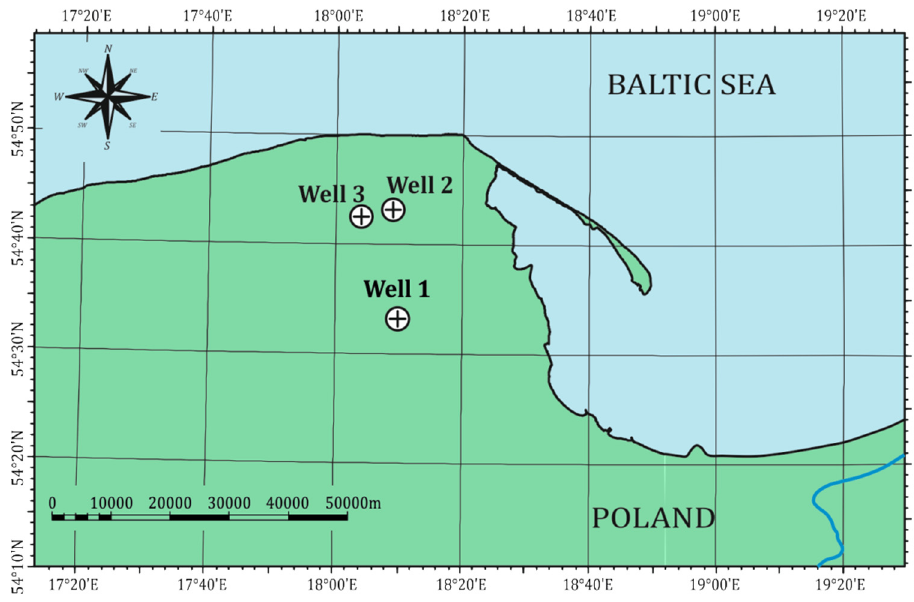
Figure 1. Locations of Well-1, Well-2 and Well-3 in the study area, north Poland, Peri-Baltic Syneclise.